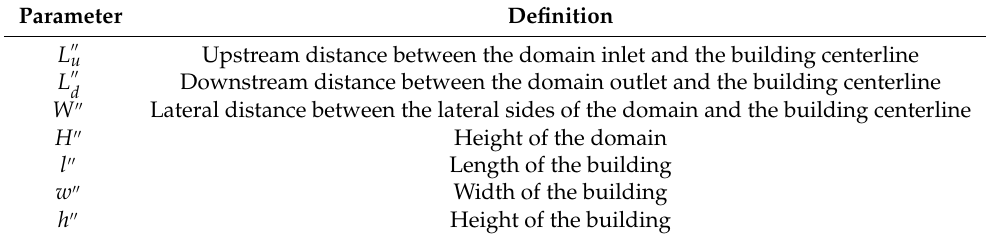
Table 1. Definition and values of the geometric parameters of the computational domain and the surface-mounted building.